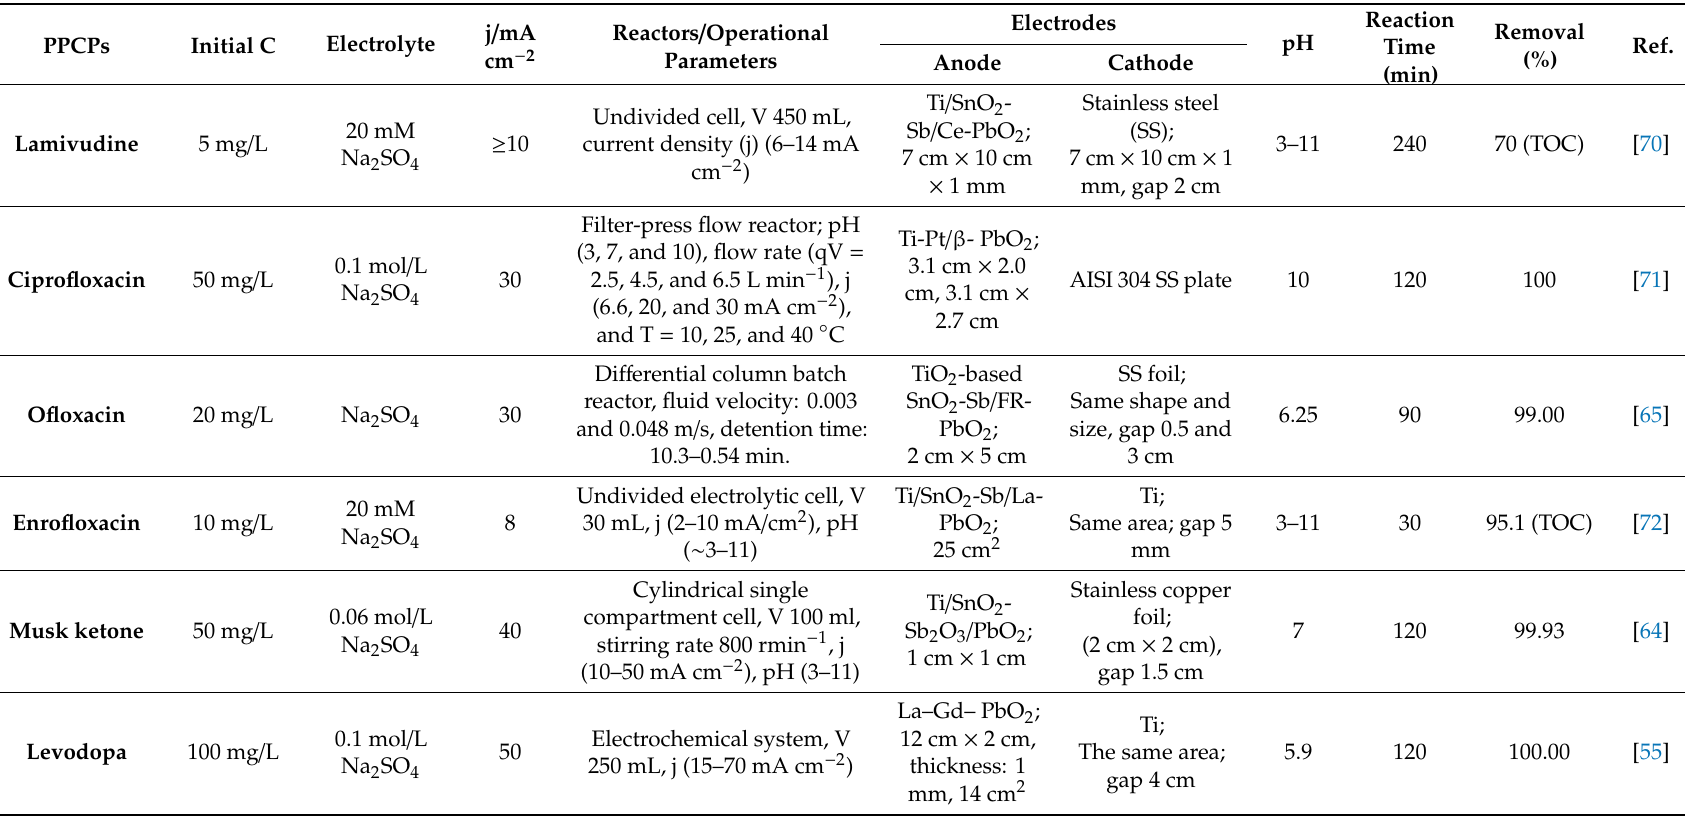
Table 4. Selected results reported for PPCPs removal by electrochemical oxidation process (EOP) with lead and lead dioxide anodes.